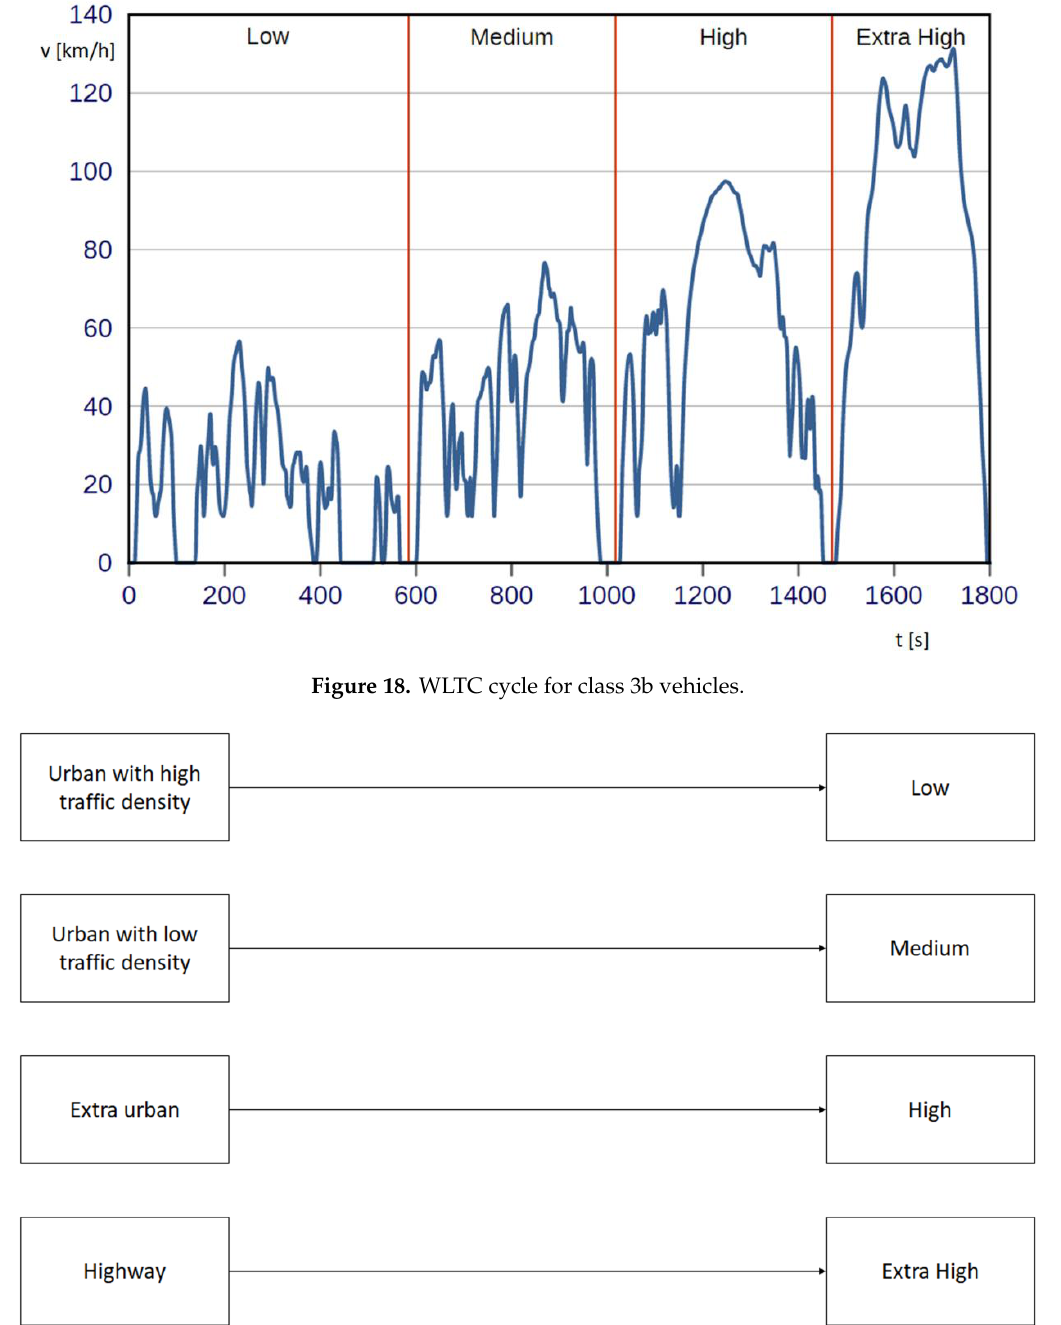
Figure 19. Scheme of calculation of energy consumption in the tests to compare with energy